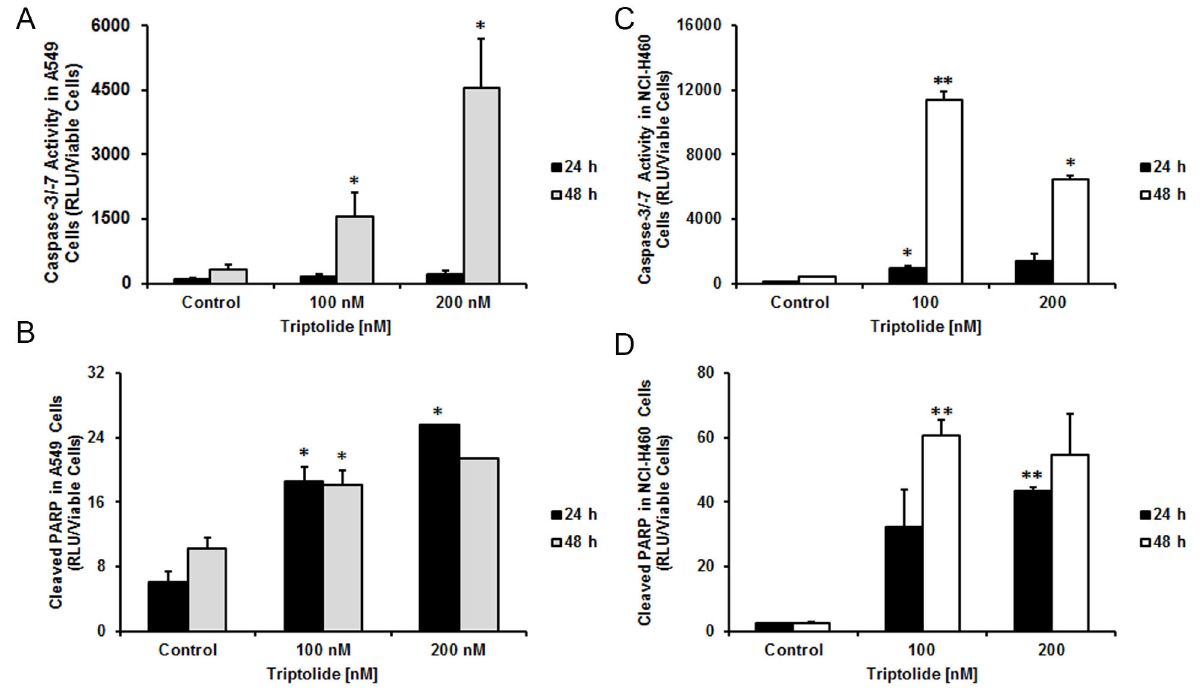
Figure 2. Triptolide induces apoptosis in NSCLC cells. NSCLC cells were exposed to 100 nM and 200 nM of triptolide for 24 and 48 hours and caspase-3/-7 activities (A, C) and PARP cleavage (B, D) were assessed. Following triptolide treatment caspase-3/-7 activity and cleavage of PARP were significantly increased compare to untreated cells demonstrating apoptosis. Columns , mean, bars , SE. Statistical significance of results was calculated with the Student`s t test (N=3) * P = 0.05; ** P = 0.005. Results were expressed after normalizing to cell